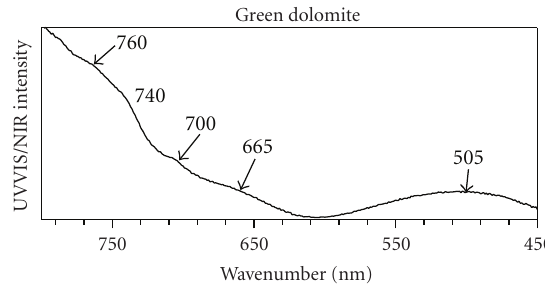
Figure 3: Optical absorption spectrum of green dolomite at room temperature.